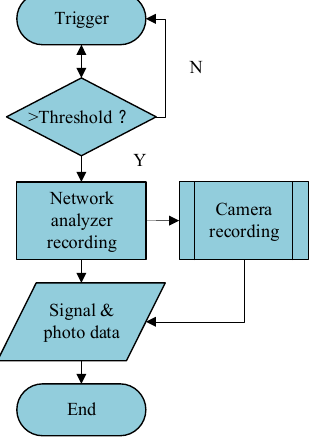
Figure 3. The flow chart of one measurement.